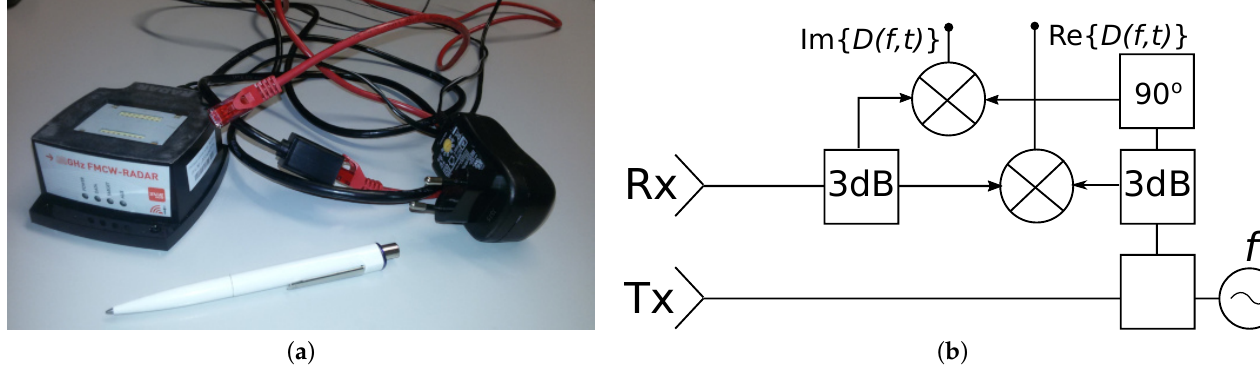
Figure 1. IMST sentire FMCW 60 GHz Radar Module: ( a ) photo; ( b ) a corresponding generalized block diagram of a CW/FMCW radar system with transmitter and receiver channels and I/Q demodulator. The diagram consists of the following elements: the signal source for the generation of a (frequency-modulated) signal, transmitter antenna (Tx), receiver antennas (Rx), mixers for the generation of the intermediate frequency, digital sampling unit; also, the device comprises other elements: couplers, filters, amplifiers, phase shifters. Antennas reside on the top of the